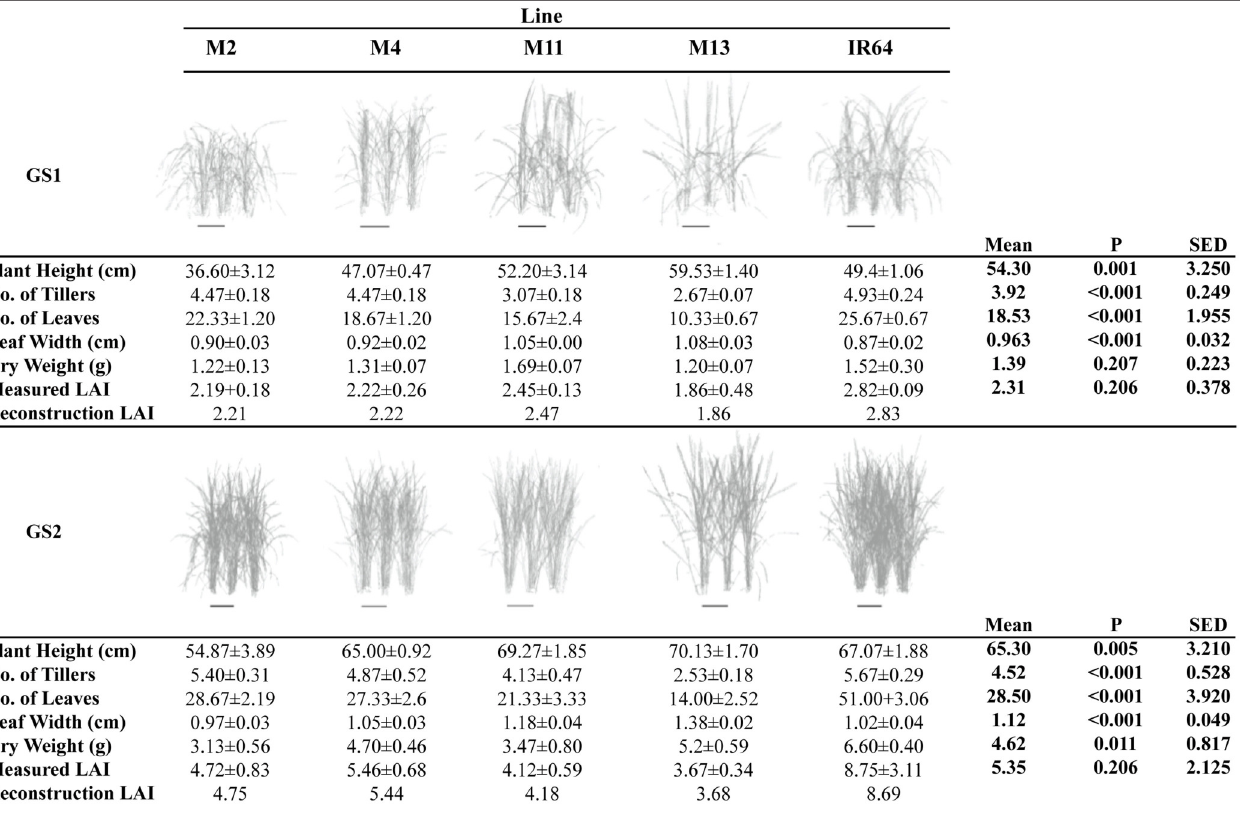
TABLE 1 | Canopy reconstructions and